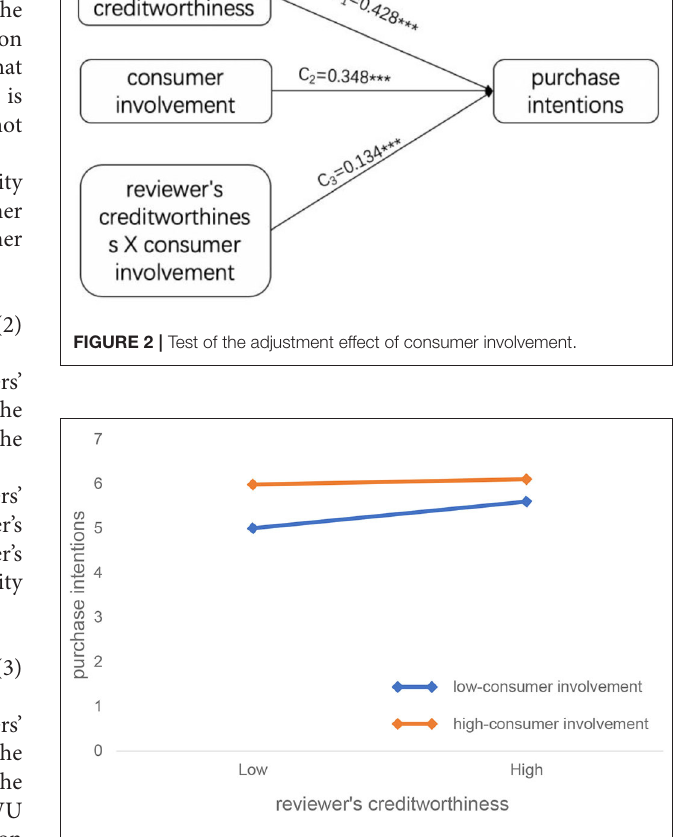
FIGURE 3 | The effect of consumer involvement on the relationship between reviewers’ creditworthiness and purchase